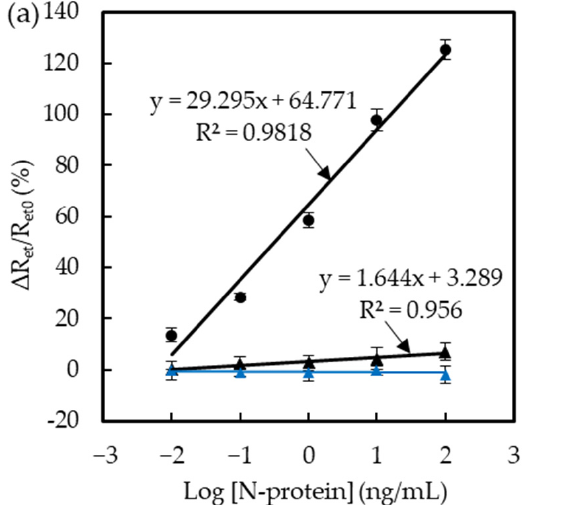
Figure 3. Specificity test of the BioAb/SA-BSA/MPA/SPCEs of different analytes in PBS. The data of the SARS-CoV-2 N-protein are retrieved from Figure 2b’ for comparison of the cross-reactivity measured by three individual sensors. The asterisk indicates a significant difference ( p < 0.05).